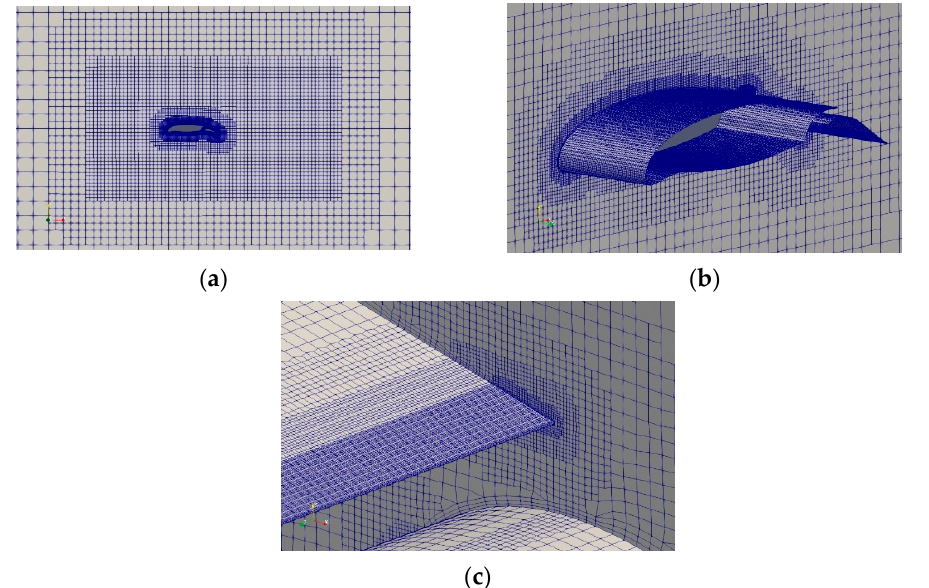
Figure 3. 3D mesh generated around profile S5HL. ( a ) CFD mesh including far field. ( b ) Detail view of CFD mesh around the wing. ( c ) Channel between the wing main part and the flap.